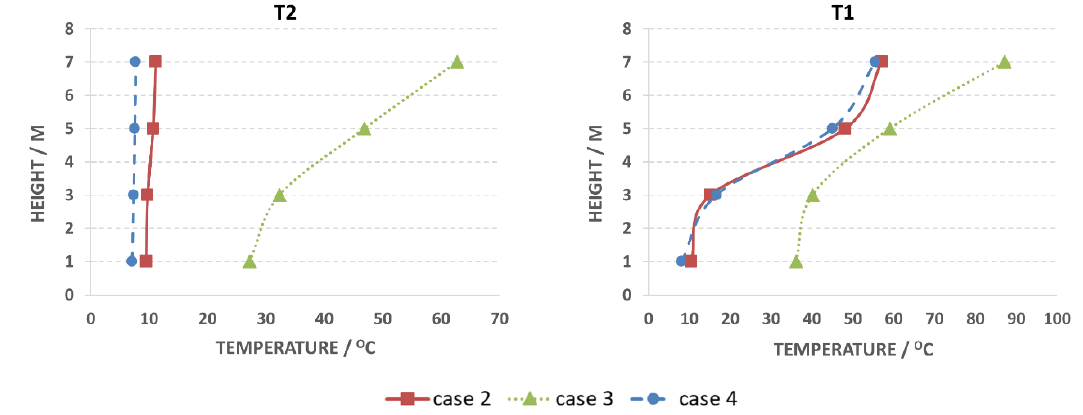
Figure 12. Temperature measurement at location thermocouple trees T1 and T2 for Case 2, 3, and 4 .